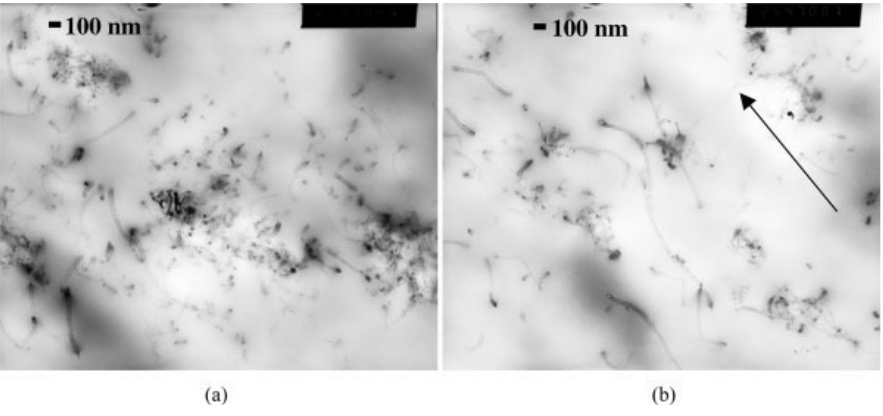
Figure 7. TEM Images of 3 wt % MWNTs in PP a) un-oriented; b) oriented, 12:1 draw ratio. Arrow indicates the direction of orientation. Reproduced with permission from ref.